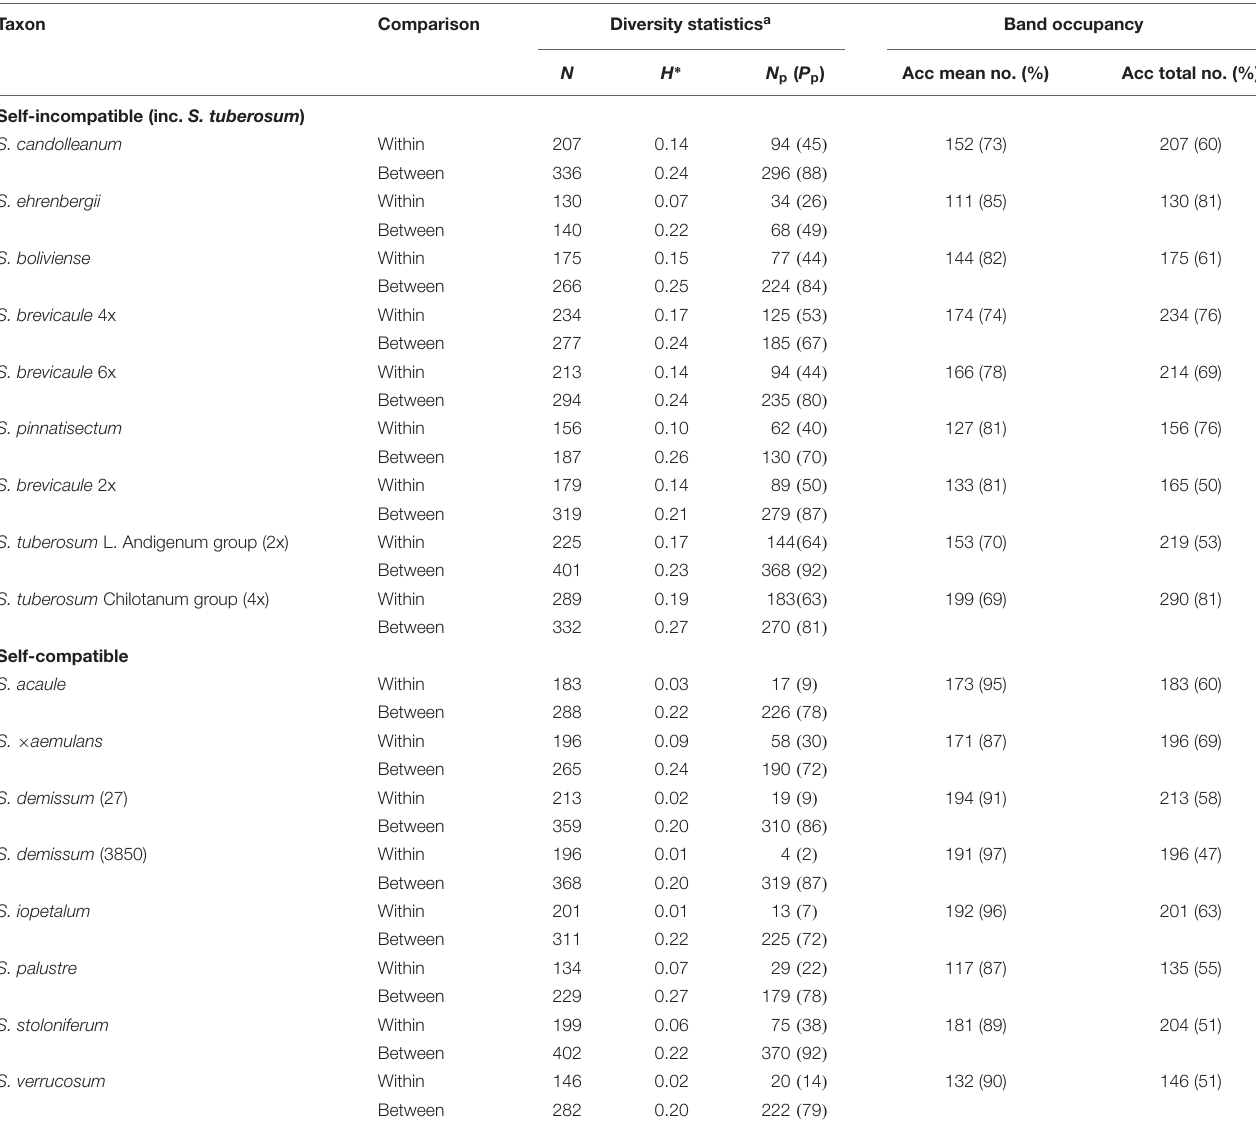
TABLE 2 | Population genetic statistics.